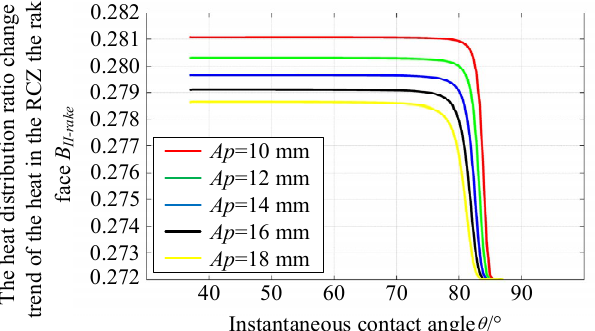
Figure 19. Heat distribution ratio of the heat source to the rake face in the RCZ at different milling depths ( V = 40 m/min).